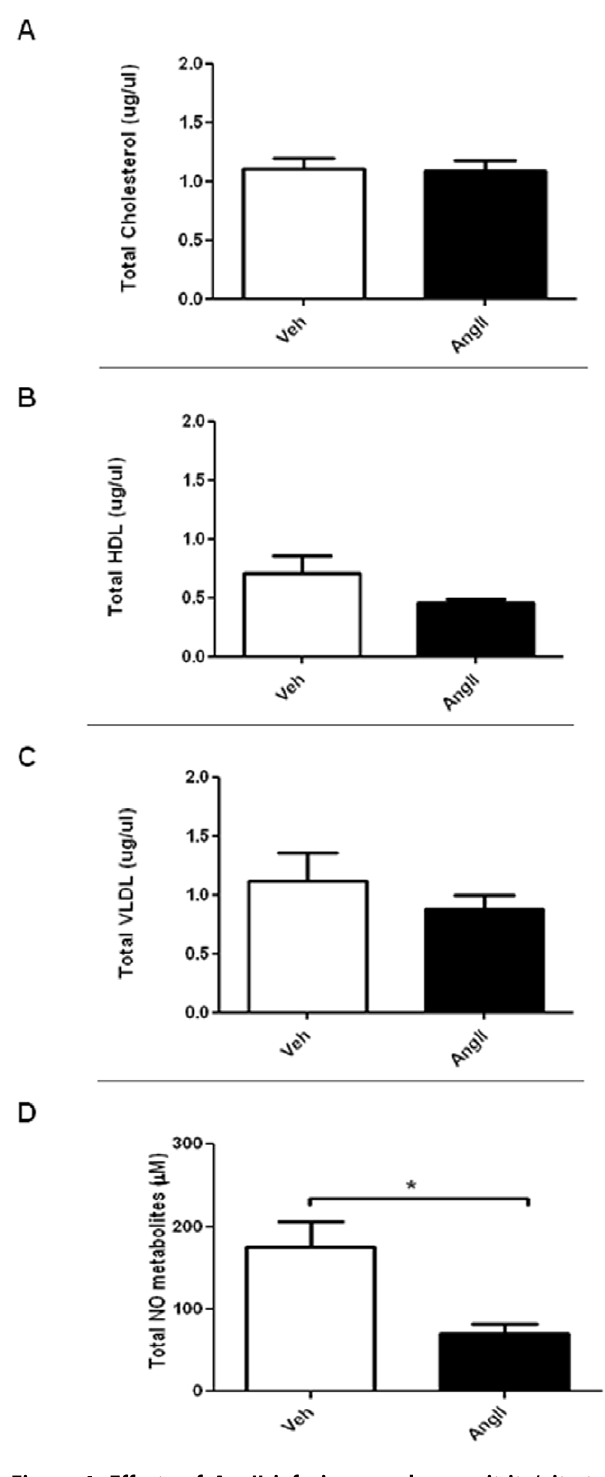
Figure 4. Effects of AngII infusion on plasma nitrite/nitrate, total cholesterol, high density lipoprotein (HDL) and very low density lipoprotein (VLDL). Box plots showing plasma (A) total cholesterol; (B) HDL, (C) VLDL and (D) total NO metabolites in saline- infused (Veh) and AngII -infused (AngII) ApoE 2 / 2 mice. Results are mean 6 SEM; n=5; Statistical significance shown as *P ,